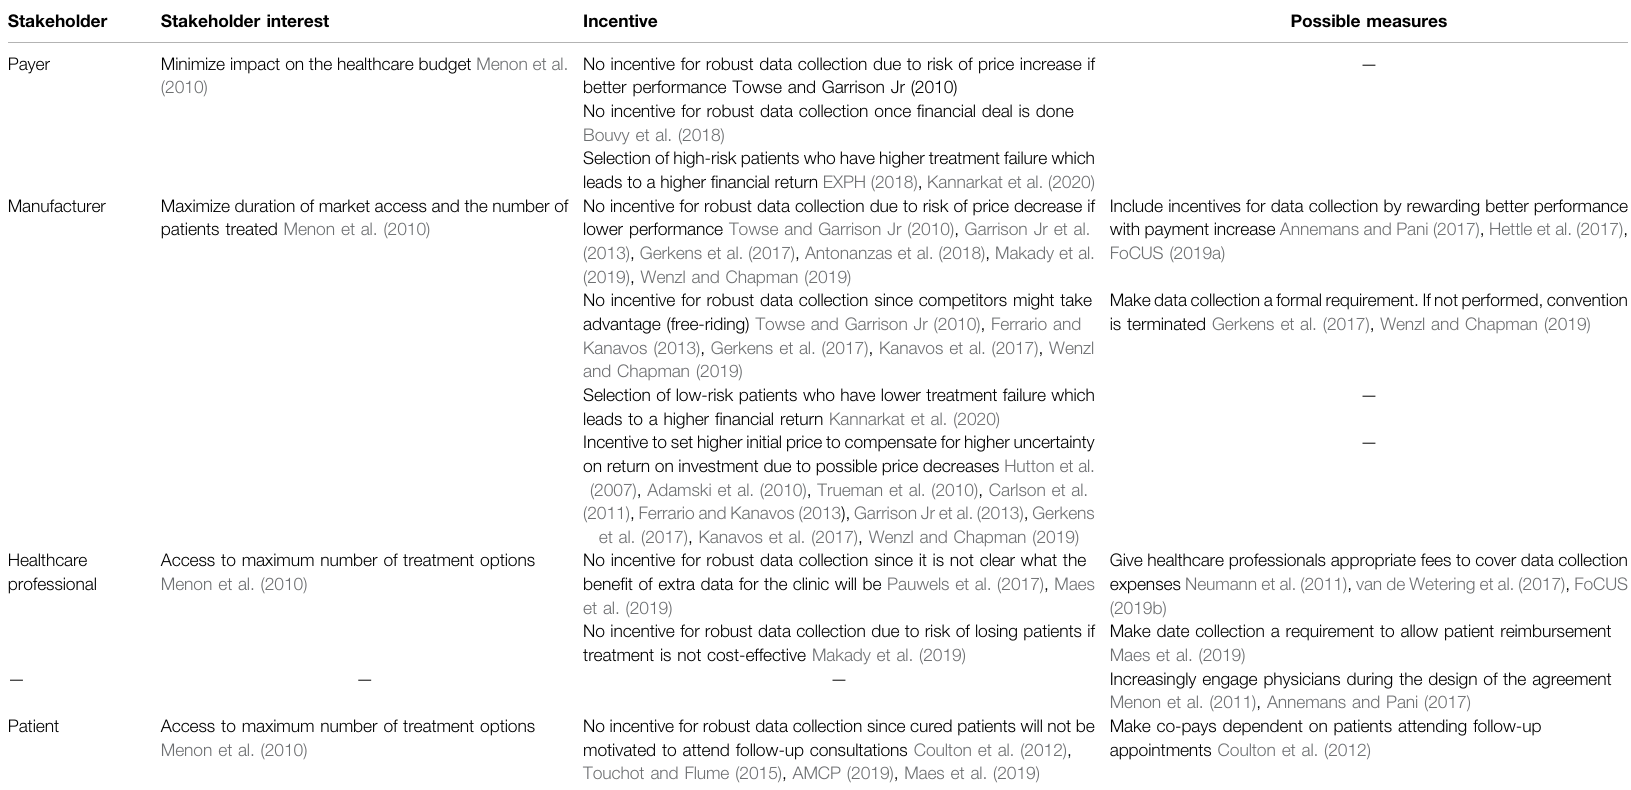
TABLE 2 | Con fl icting interests and incentives of stakeholders during outcome-based agreements and possible facilitators to mitigate negative incentives as reported in literature.